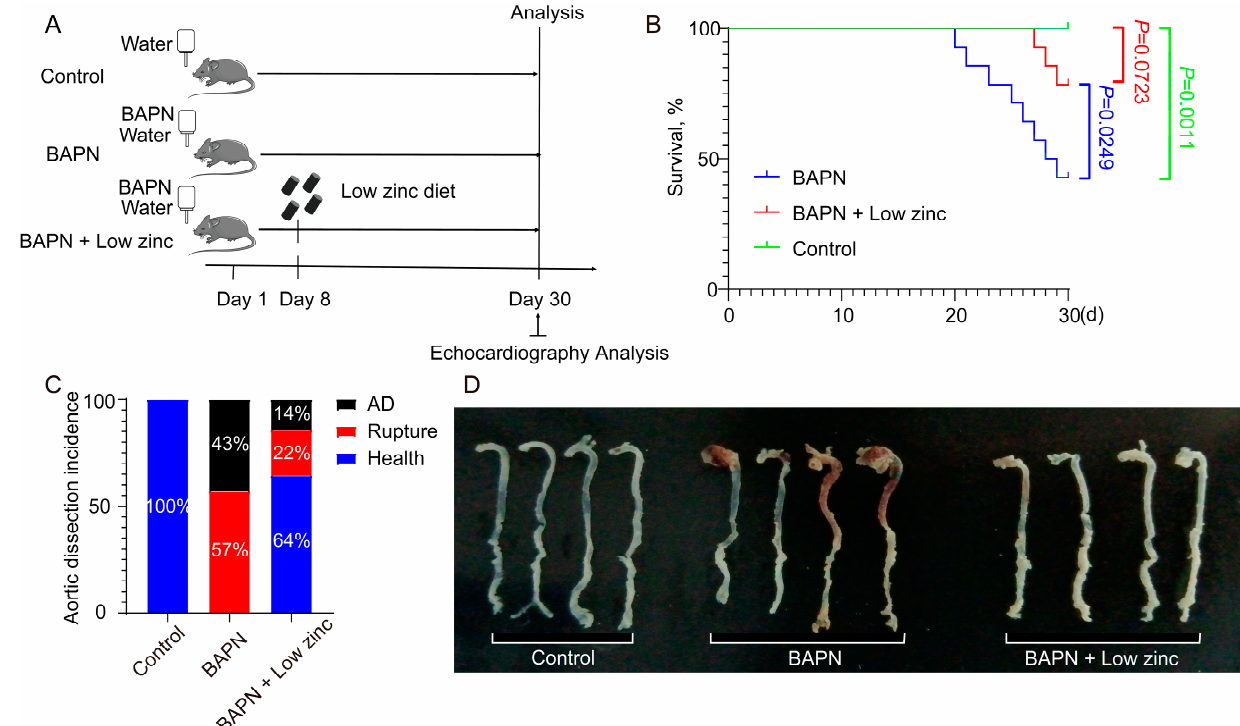
Figure 1. Low zinc represses TAD progression. ( A ) Experimental design diagram. ( B ) The survival rate was estimated by the Kaplan-Meier method and compared by log-rank test ( n = 14 per group). ( C ) TAD incidence. ( D ) Representative macrographs of the aorta.